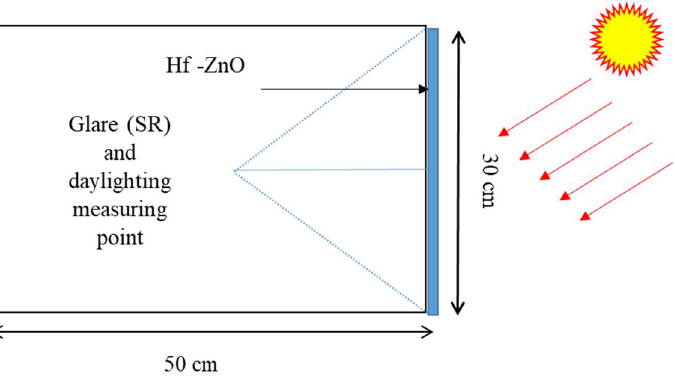
Figure 2. Schematic cross-section of a room with perovskite glazing mounted on vertical south fa- cade.